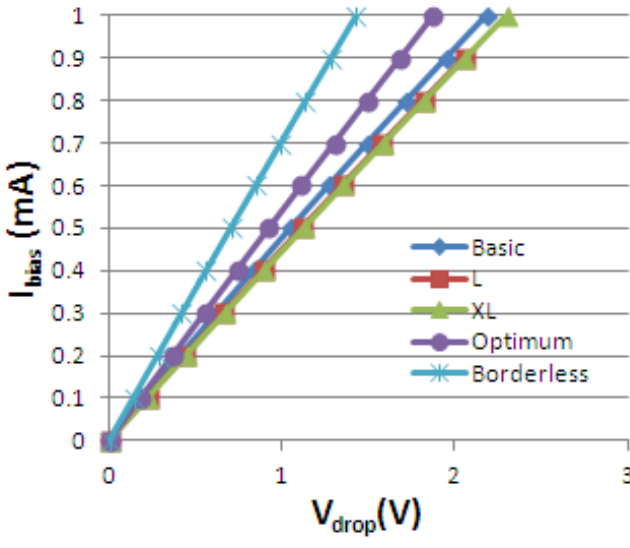
Figure 7. The simulated Hall devices I-V characteristics.